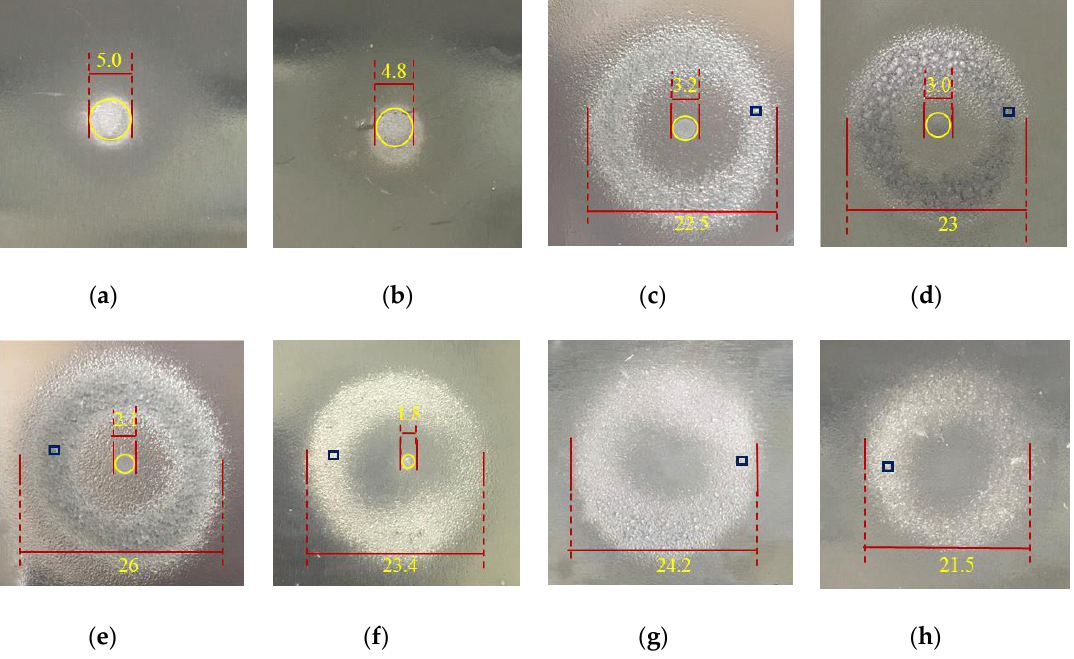
Figure 7. Surface morphology change of the samples after impact by the submerged cavitation jet under different target distances (Unit in mm): ( a ) target distance of 15 mm; ( b ) target distance of 20 mm; ( c ) target distance of 25 mm; ( d ) target distance of 30 mm; ( e ) target distance of 35 mm; ( f ) target distance of 40 mm; ( g ) target distance of 40 mm; ( h ) target distance of 50 mm.